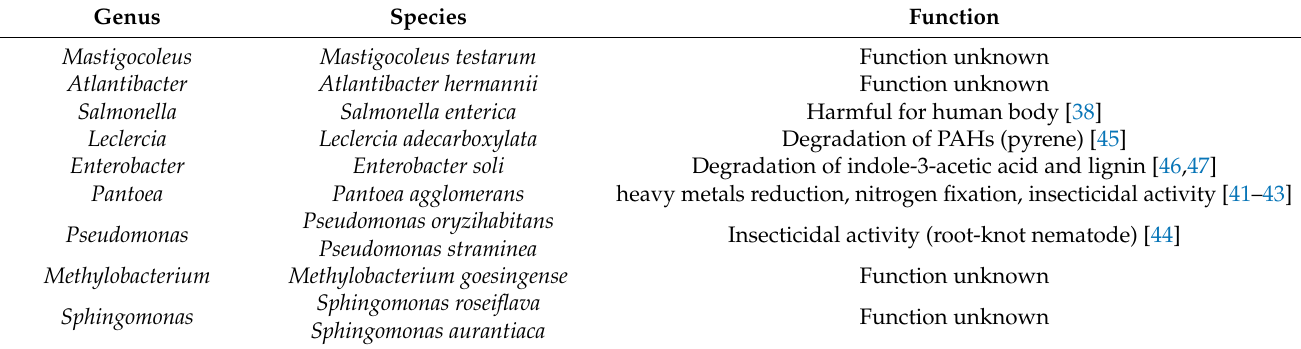
Table 1. The list of the national core microbial